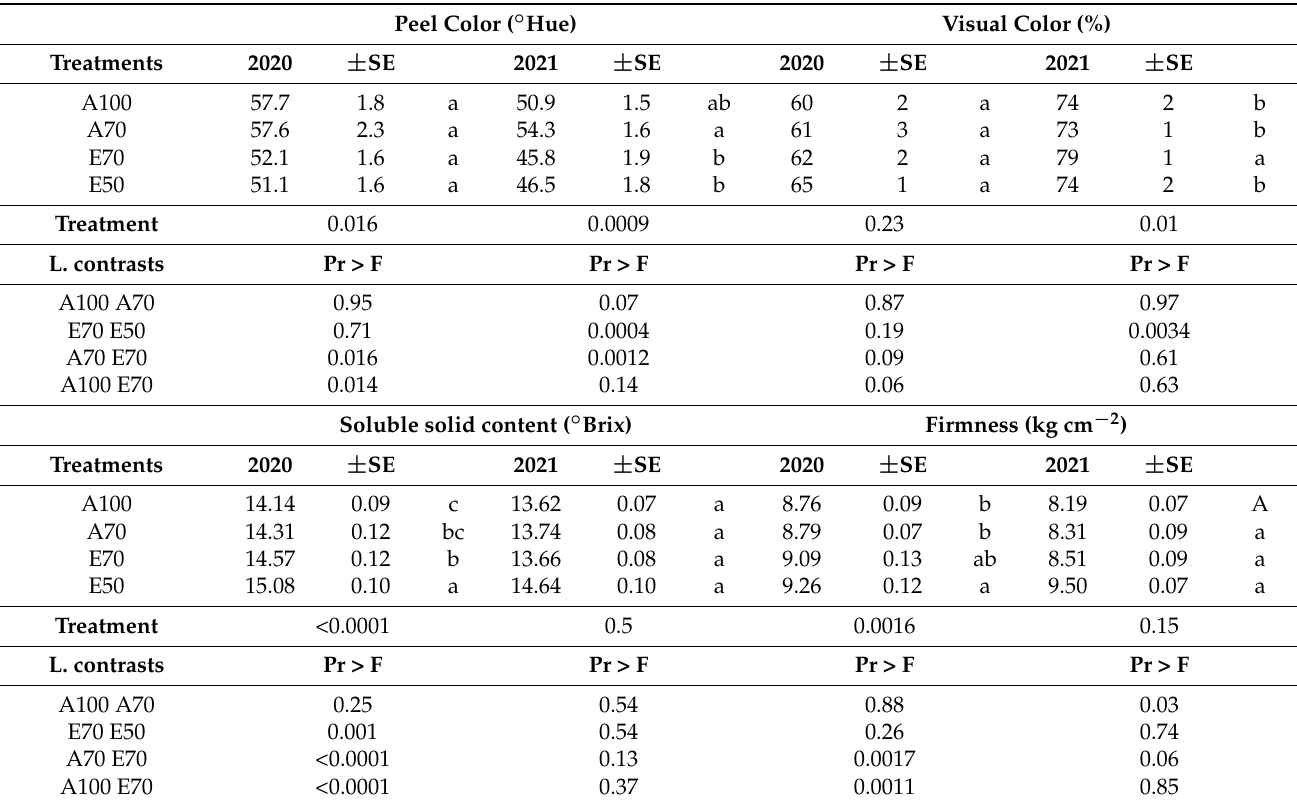
linear contrast F values for each year are shown; values below 0.05 are considered significant.